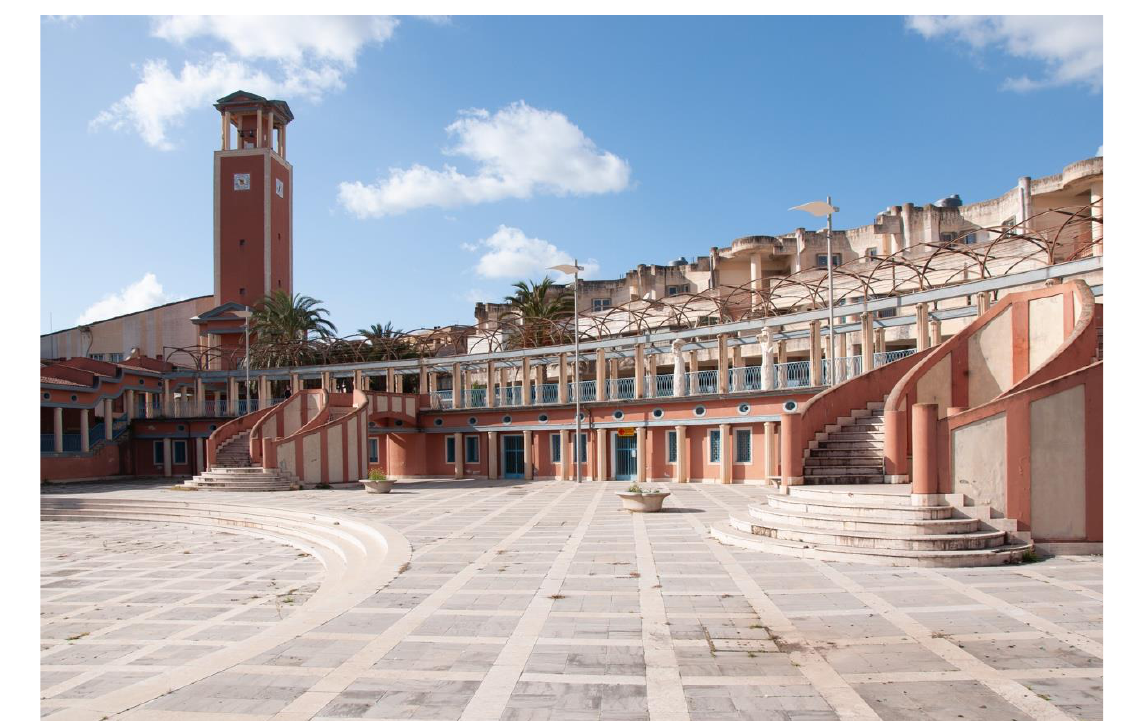
Figure 10. Piazza Elimo, Poggioreale nuova, project by Paolo Portoghesi (1988). Photo by the authors, Poggioreale Nuova 2020.